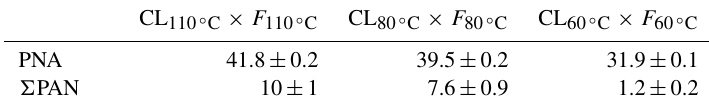
Table 5. Products of CL and F for PNA and PAN at 110, 80, and 60 ◦ C (RH = 34%).